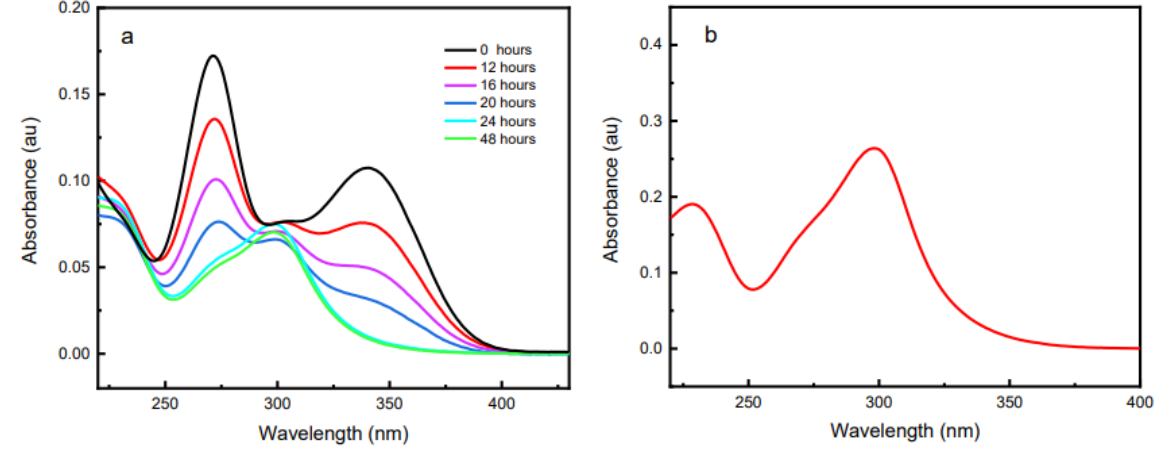
Figure 14. UV-vis spectroscopy of ( a ) P2T inhibited immersion solution over different time